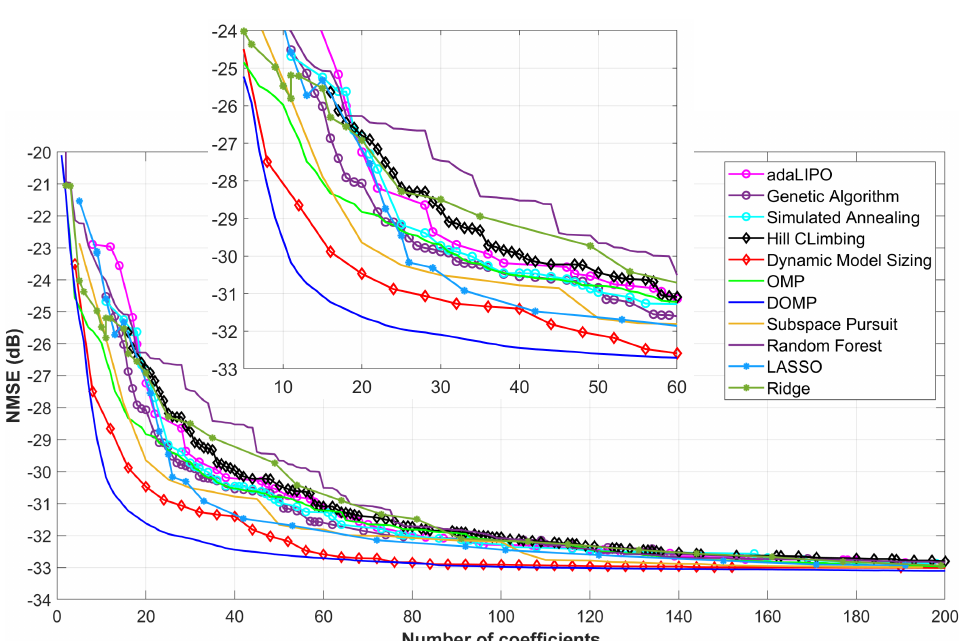
Figure 5. NMSE versus the number of coefficients when considering different feature selection techniques.